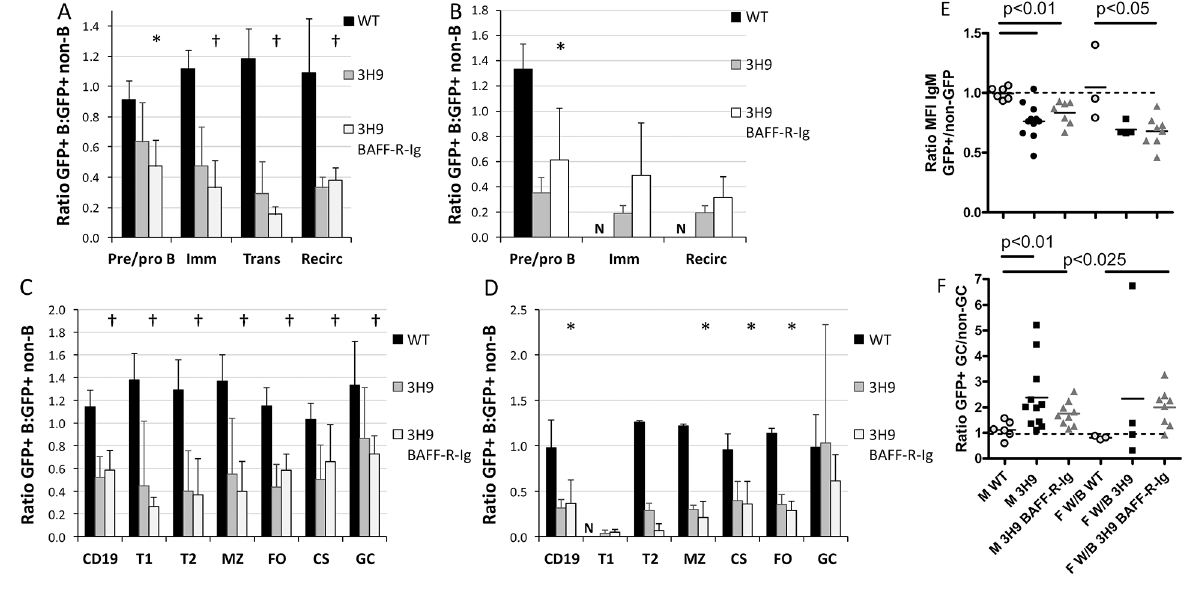
Figure 3. Deletion of 3H9 B cells occurs in the bone marrow and is not further affected by BAFF-R-Ig. (A, B) Ratio of GFP + B cells to GFP + non–B cells in bone marrow subsets shows deletion occurring at the pre–B cell stage in the 3H9 chimeras. Further deletion occurred between pre–B cells and recirculating B cells (Imm, Immature; Trans, transitional; Recirc, recirculating). (C, D) Ratio of GFP + B cells: GFP + T cells in spleens shows no further deletion after the T1 stage and no difference between 3H9 untreated and BAFF-R-Ig–treated chimeras. n = 4–8 per group; symbols show comparisons of ratios of BAFF-R-Ig–treated mice with those of wild-type counterparts: * p < 0.05, † p < 0.01, compared with wild-type chimeras. (E) Downregulation of sIgM as assessed by the ratio of sIgM on GFP + follicular B cells: sIgM on GFP – follicular B cells occurs in all the 3H9 chimeras and is not altered by BAFF-R-Ig treatment. (F) Overrepresentation of 3H9 B cells among GC B cells in 3H9 chimeras, as assessed by the ratio of GFP + GC cells: GFP – GC cells is not influenced by BAFF-R-Ig